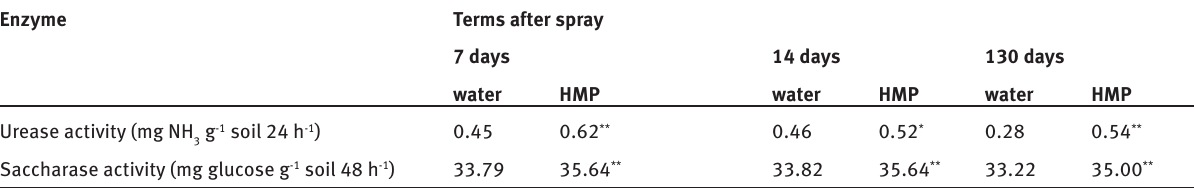
Table 2: The influence of spraying with horn-manure preparation on the activity of soil enzymes Enzyme Terms after